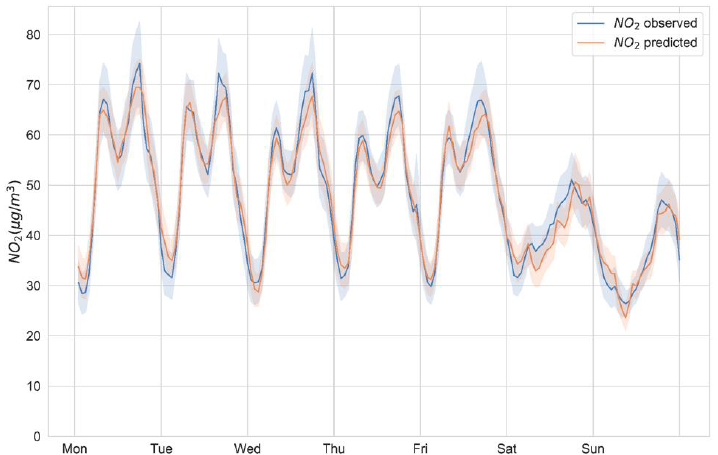
Figure 4. Average weekly pattern of the observed and predicted NO 2 values in 2017 with a 95% confidence interval (bootstrapped).